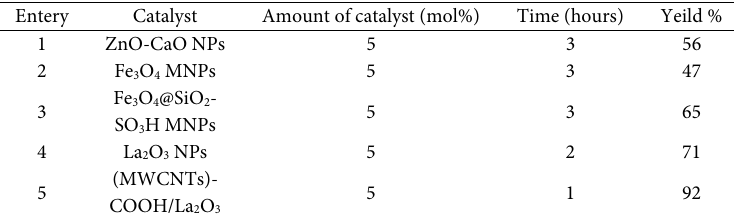
Table 4. Recycling of the (MWCNTs)-COOH/La 2 O 3